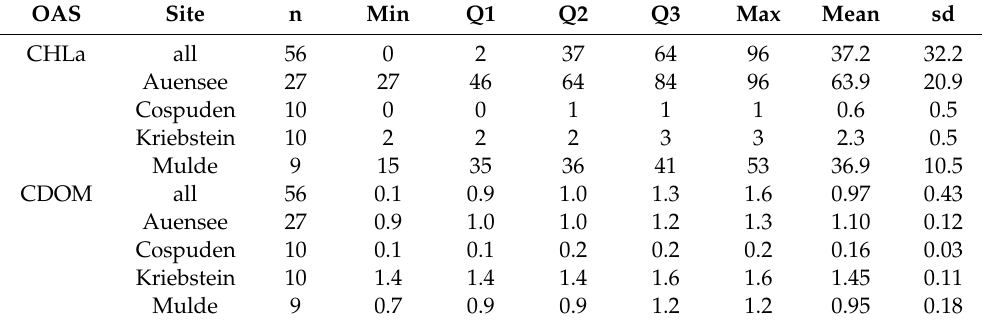
Table 2. Descriptive Statistics of reference values of chlorophyll a—contents (CHLa, in µ g L − 1 ) and CDOM absorbance at 440 nm (in m − 1 ). OAS = optically active substance, n = number of samples, min = minimum, Q1 = first quartile, Q2 = median, Q3 = third quartile, max = maximum, mean = arithmetic mean, sd = standard deviation.